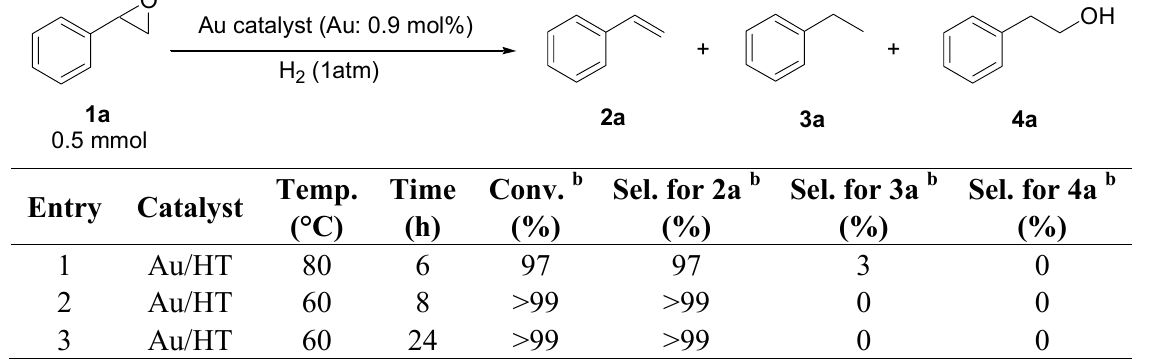
Table 5. Deoxygenation of styrene oxide using H